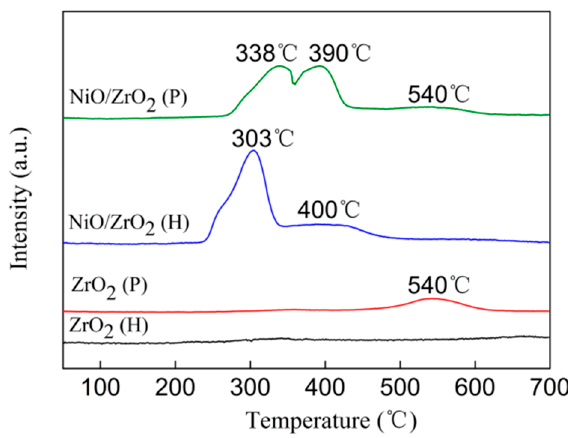
Figure 5. H 2 -TPR profiles of ZrO 2 supports and NiO/ZrO 2 catalysts.